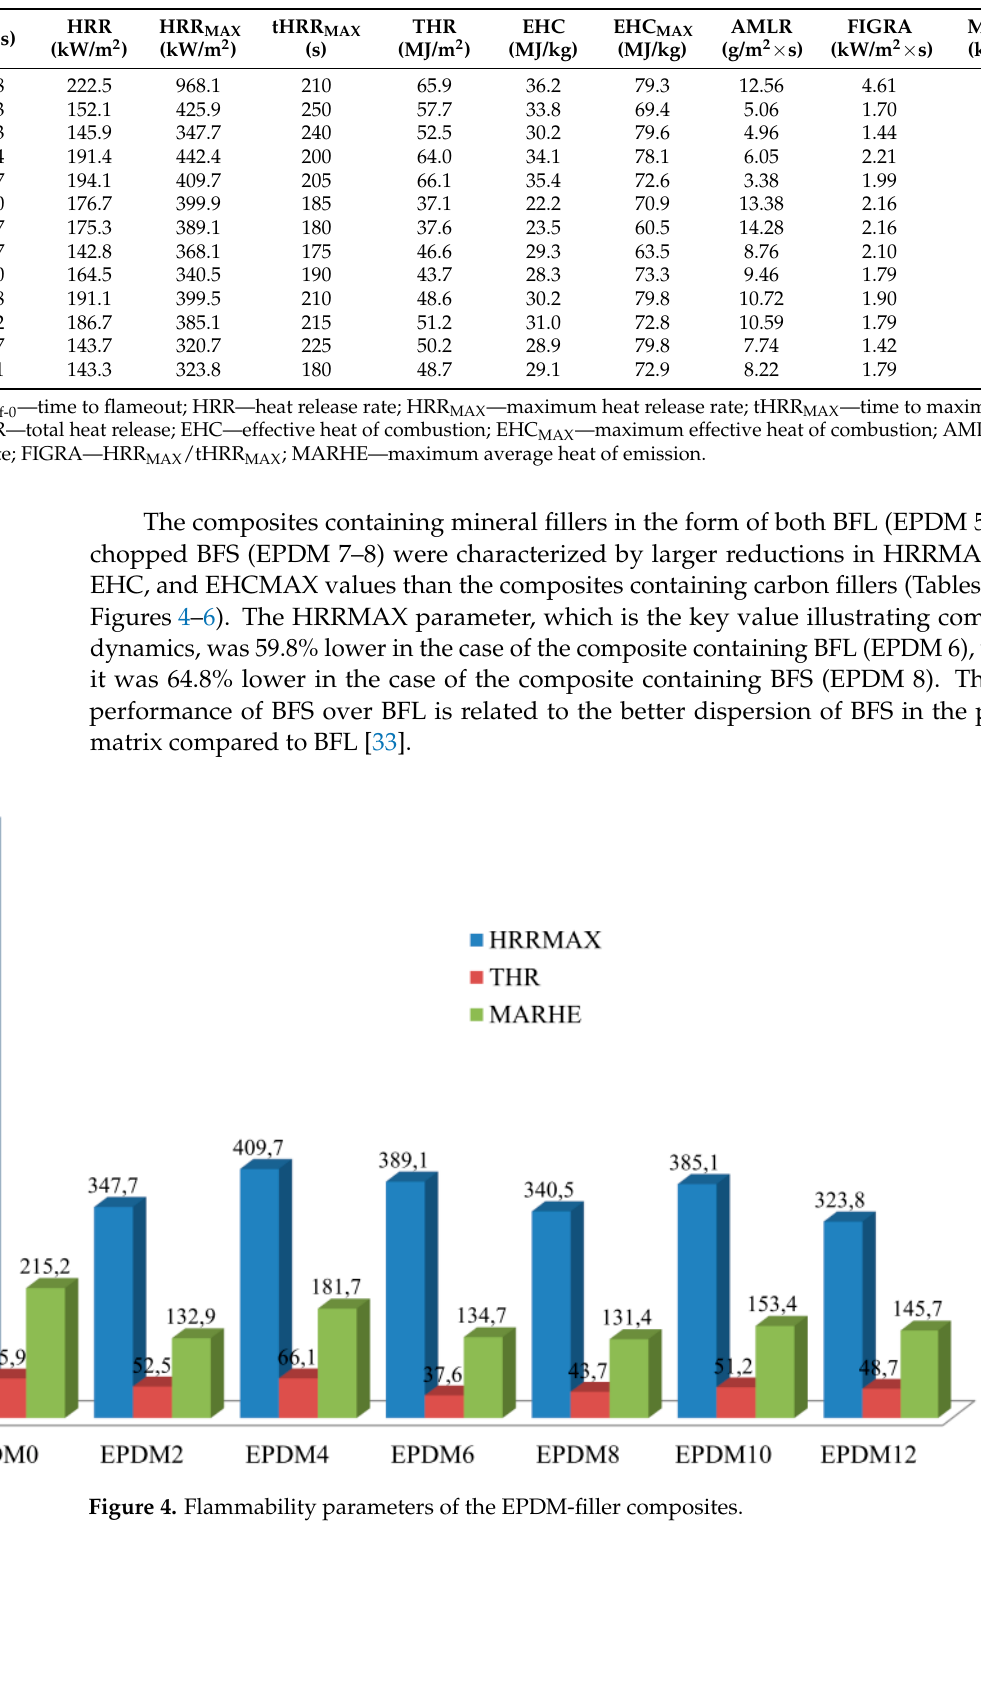
Table 4. Cone calorimetry flammability test results for EPDM composites.